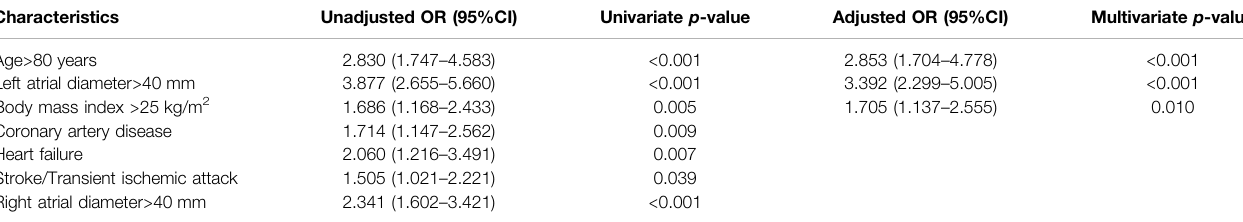
TABLE 2 | Results of univariate and multivariate logistic regression analysis for identifying predictors of advanced interatrial block. Characteristics